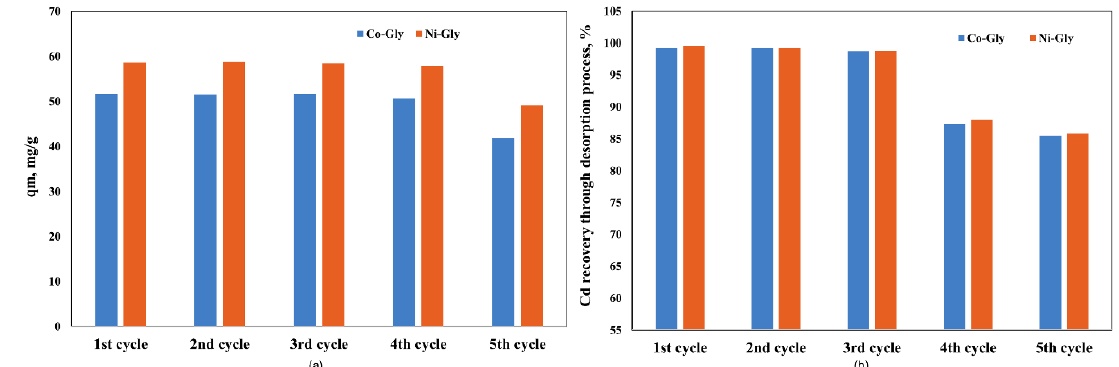
Figure 6. The adsorption performance of the studied CNs in various adsorption-desorption cycles ( a ) the adsorption capacity, after each cycle ( b ) Cd recovery, after each cycle.